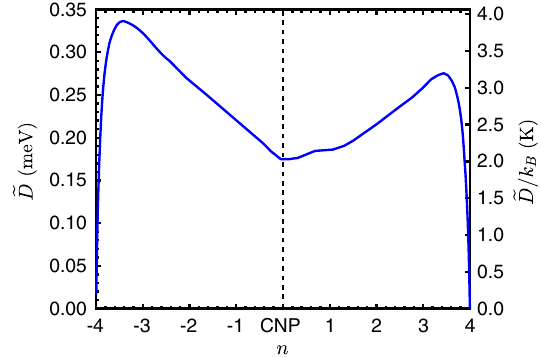
˜ D FIG. 1. as a function of doping from the charge neutrality point (CNP) in magic-angle twisted bilayer graphene (MATBG), calculated using the band structure of Ref. [17] at T ¼ 0 . ˜ D is the integrated optical spectral weight and π ð 2 π e 2 = ℏ 2 Þ is an upper bound on the SC T c in MA